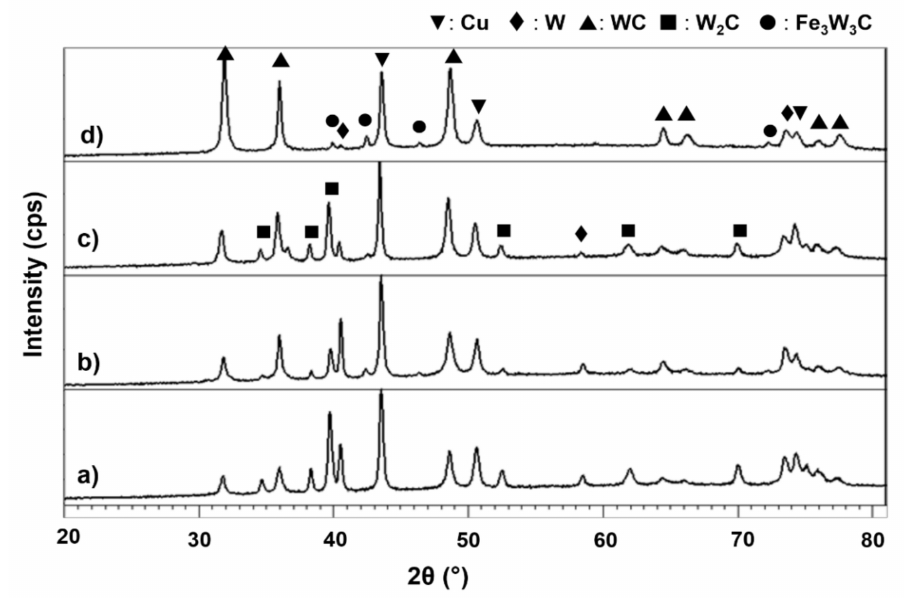
Figure 7. XRD patterns of Cu-W-C sintered composite milled for ( a ) 10 h ( b ) 20 h, ( c ) 40 h and ( d ) 60